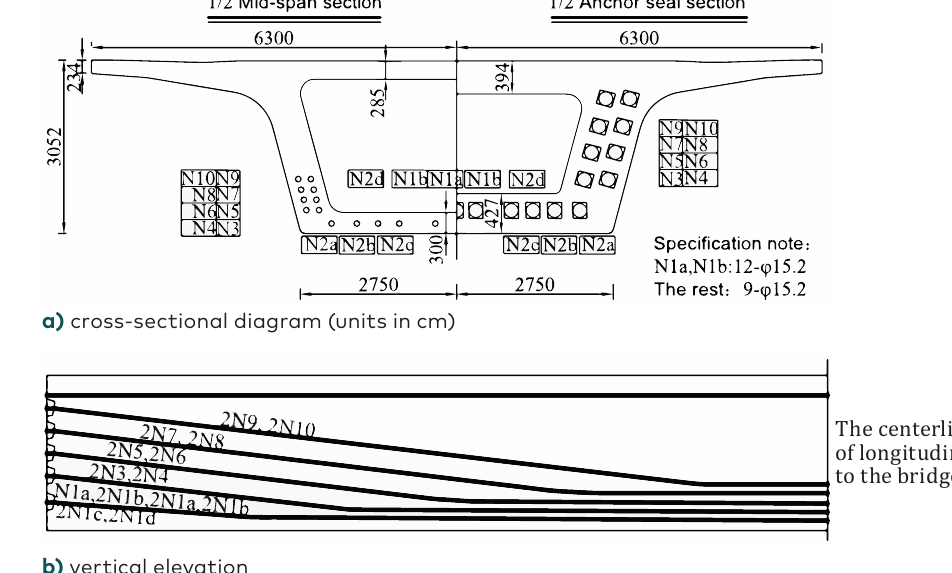
b) vertical Figure 1. Layout of prestressed steel wires of box girder